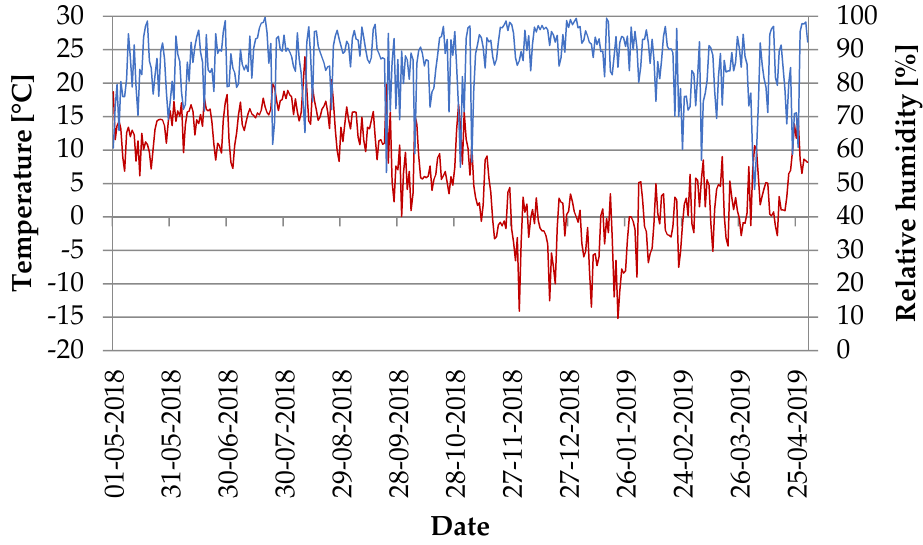
Figure 4. The course of temperature and relative humidity of the air outside.